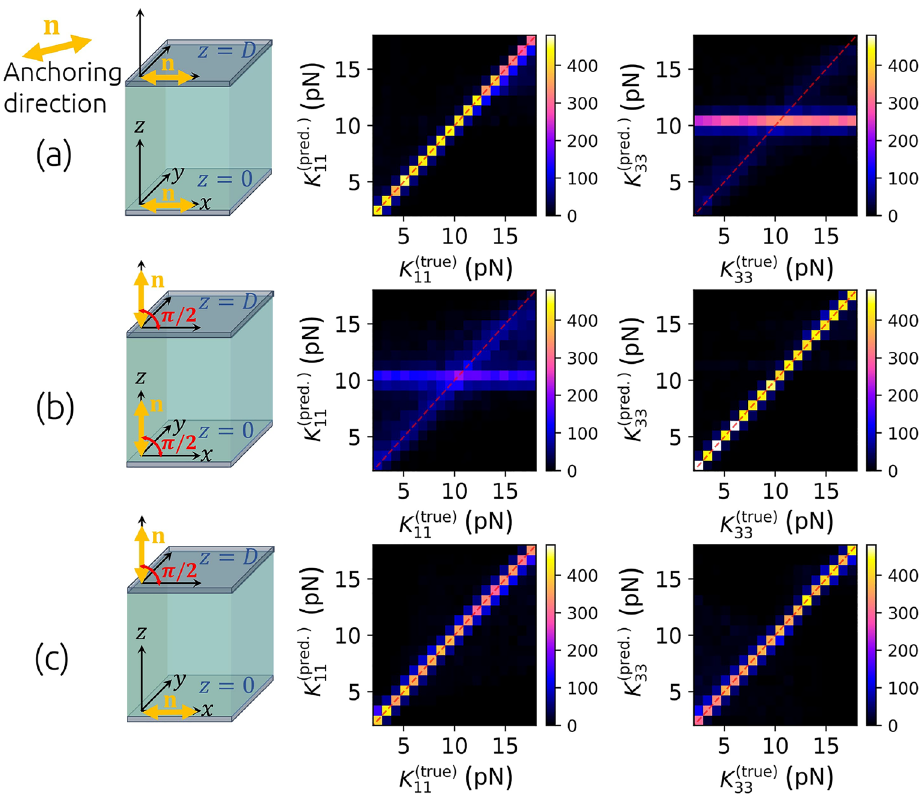
Figure 3. Comparison of predicted and actual elastic constants K 11 and K 33 from the validation data set with n ( z , t ) = ( cos θ( z , t ) , 0, sin θ( z , t )) director geometry and three different combinations of anchoring. Planar- planar geometry ( a ) allows for precisely predicting K 11 but not K 33 , using homeotropic-homeotropic geometry ( b ), K 33 can be determined, whereas in planar-homeotropic geometry ( c ), one can train a neural network to determine both elastic constants K 11 and K 33 at once. The planar-homeotropic configuration is later also used in